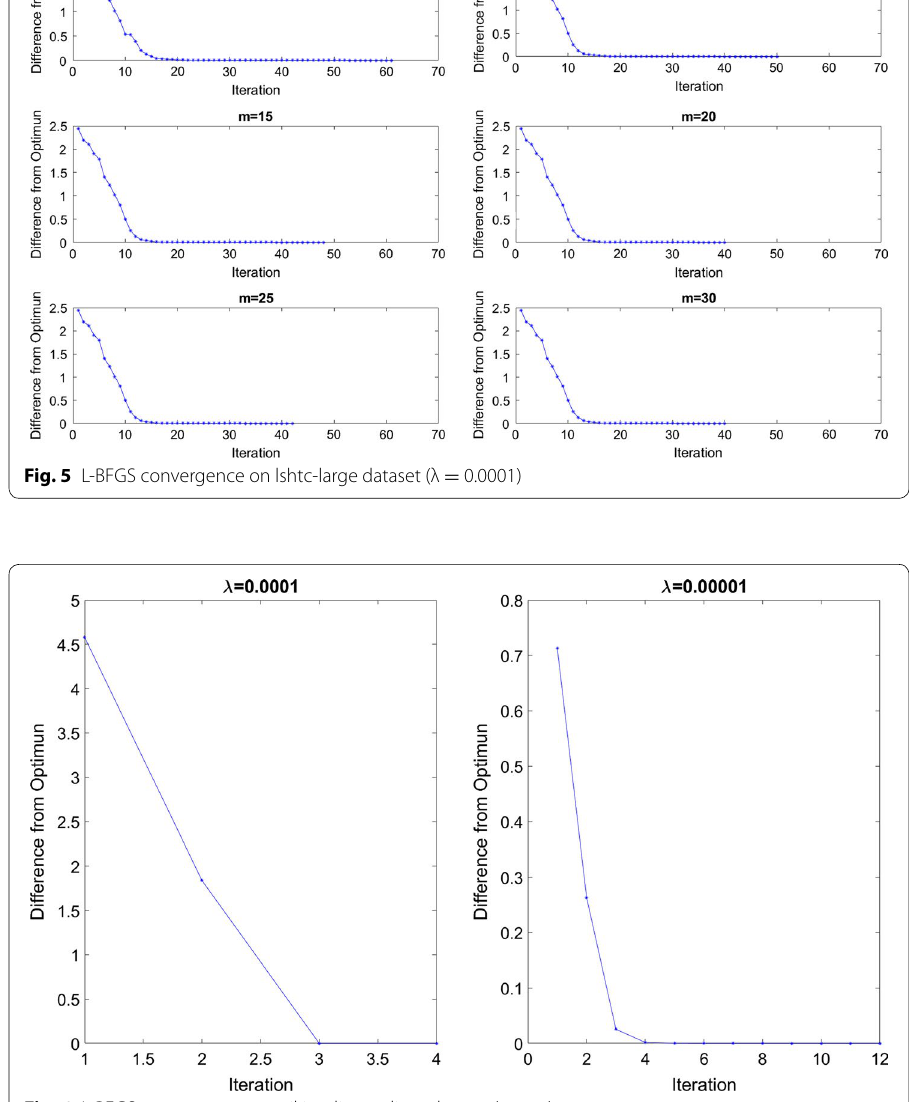
Fig. 6 L-BFGS convergence on wikipedia-medium dataset ( m = 5